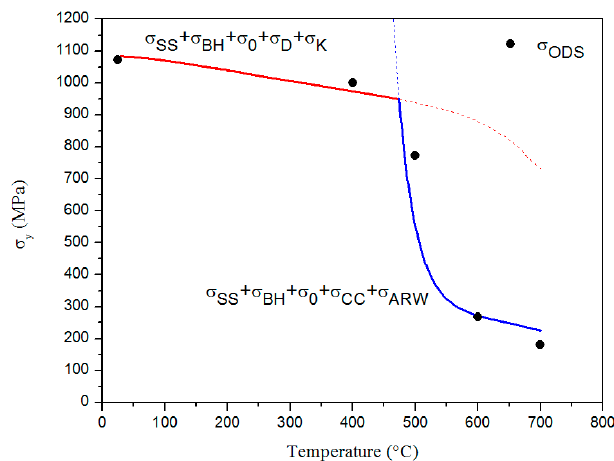
Figure 8. Yield stress values of ODS are compared with different strengthening contributions, namely solid solution ( σ SS ), dislocations ( σ BH ), friction stress ( σ 0 ), grain size ( σ D ), Orowan ( σ K ), Arzt-R˝osler-Wilkinson ( σ ARW ), and Coble creep ( σ CC ).